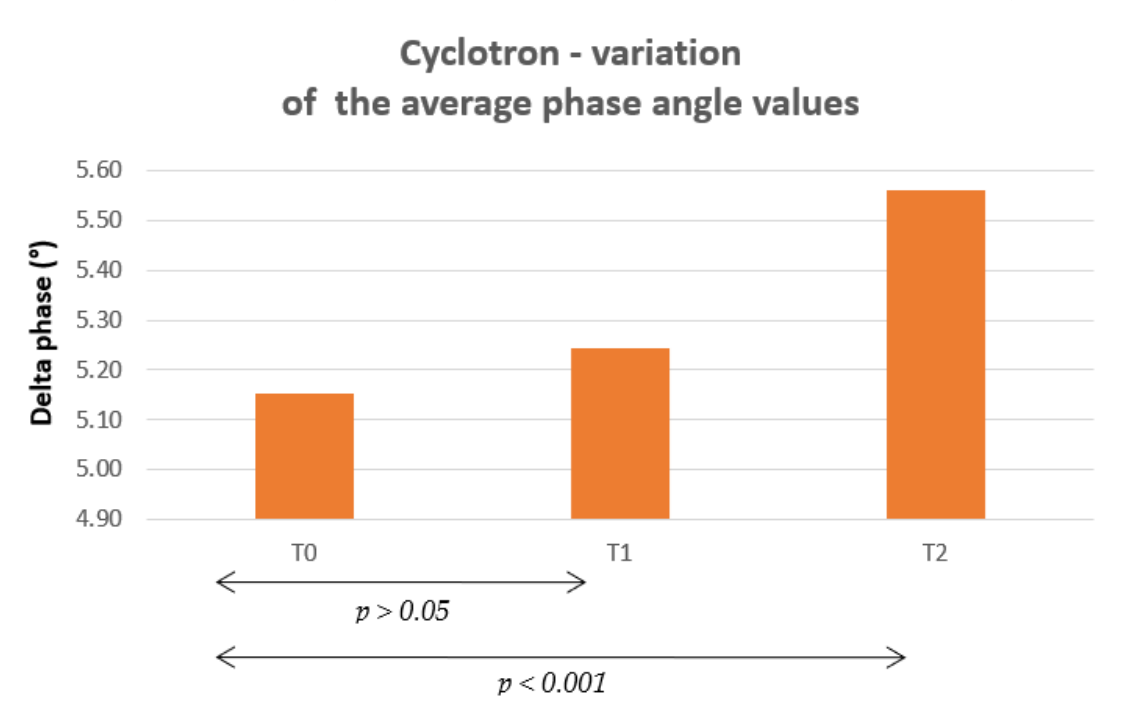
Figure 4. After exposure to ion-cyclotron emission, average phase angle statistically significantly increases at T2, in selected acupuncture points.